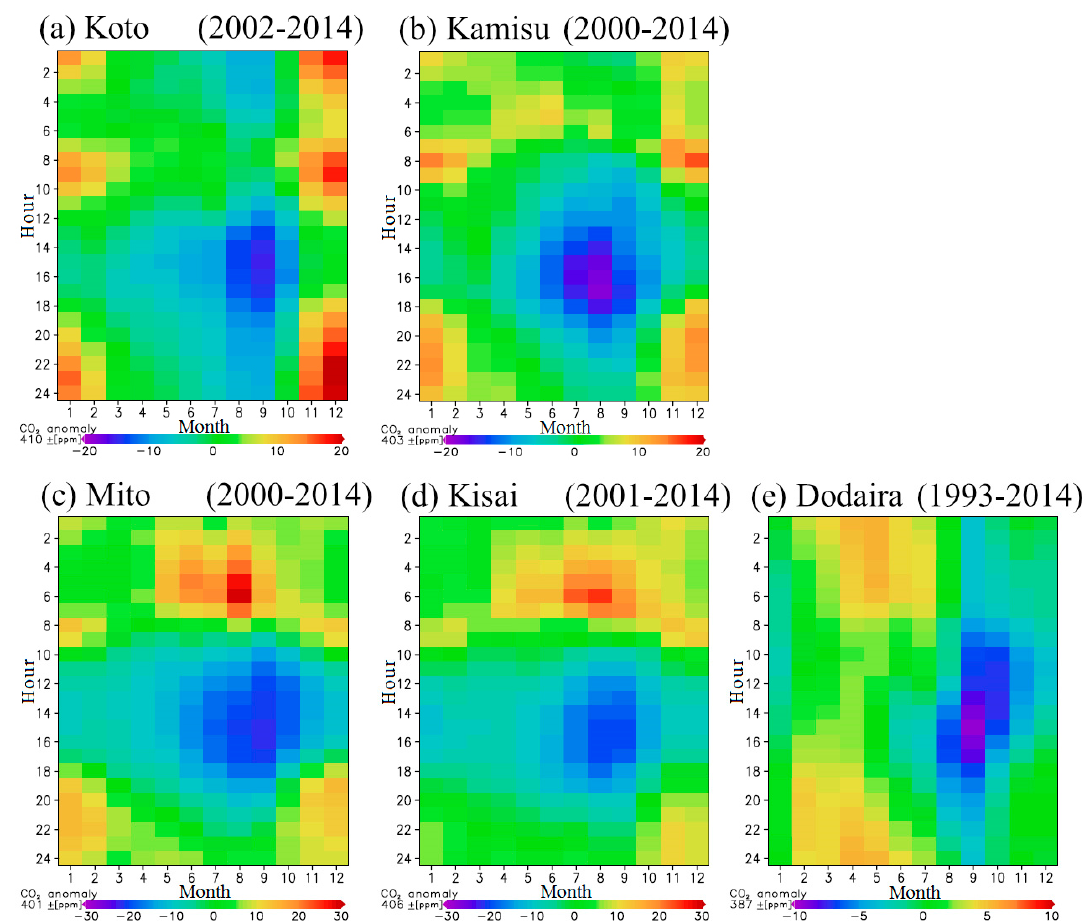
Figure 4. Diurnal–monthly anomalies of CO 2 concentration for five sites; ( a ) Koto, ( b ) Kamisu, ( c ) Mito, ( d ) Kisai, and ( e ) Dodaira. Anomalies are calculated as composites of differences between hourly data and annual mean values calculated using the running mean centered at each hourly datum with a one-year window. Observational periods used for calculations are shown in the respective plots.